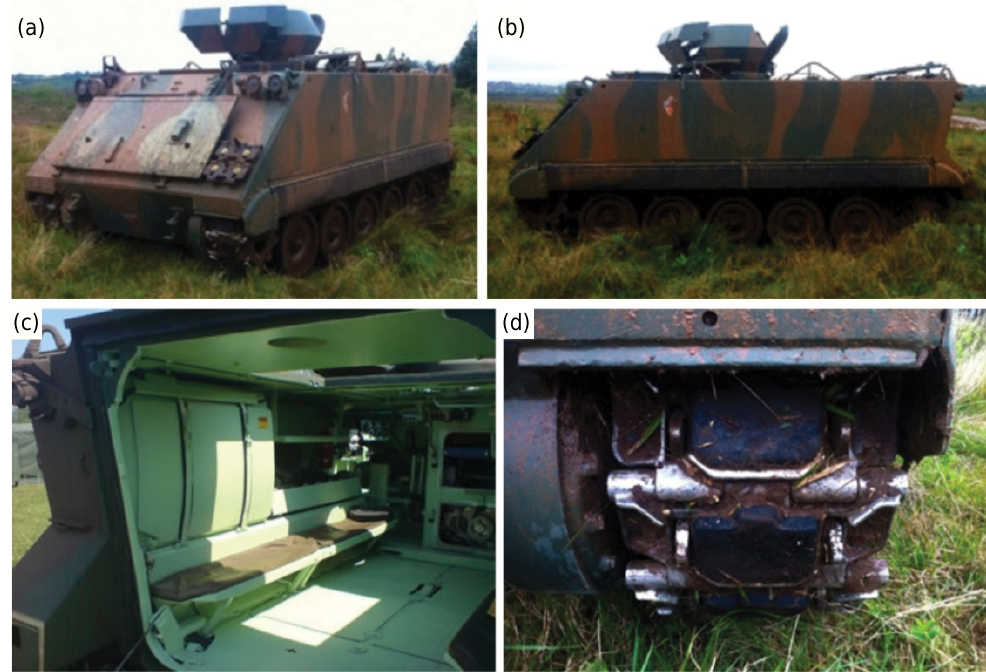
Figure 2. The military armored tracked vehicle of troops transport “M113 BR” used in the experiment: front view (a), side view (b), load compartment (c), and wheeled track (d).